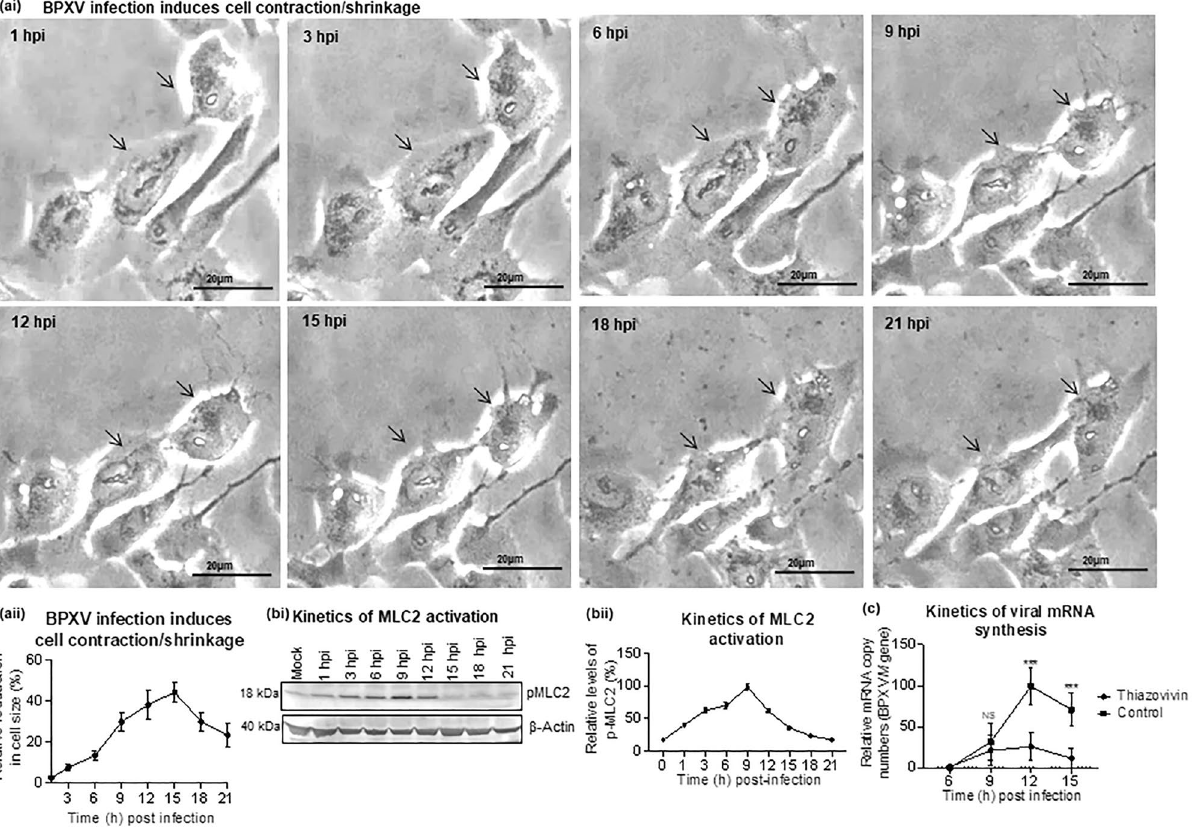
Figure 4. ROCK1/p-MLC2 signaling mediated cell contraction following BPXV infection is prerequisite for the stability of viral mRNA. ( a ) BPXV infection induces cell contraction (membrane blebbing). Vero cells were grown in chamber slides and infected with BPXV at an MOI of 5 for 1 h. Cells were subjected to live imaging. Cell morphology of BPXV infected cells at different time points are shown (ai). The histogram shows the relative reduction in cell size at different times post-BPXV infection (aii). To quantify BPXV-induced cell shrinkage, fifty cells were selected and the change in their size was measured by ImageJ at different times post-infection. The relative change in cell size (shrinkage) was expressed as a % of cell size immediately after viral infection (~ 1hpi) and the data are presented as mean with SD. ( b ) Kinetics of MLC2 activation. Vero cells were either mock-infected or infected with BPXV at MOI of 5. Cell lysates were prepared at indicated time points and subjected for detection of p-MLC2 levels in Western blot analysis. The levels of pMLC2 (upper panel) and β-actin (house-keeping control protein, lower panel) are shown (bi). The line diagram (bii) shows the band intensity of the protein. The blots were quantified by densitometry (ImageJ) and the data are presented as mean with SD. n = 3 independent experiments. See Supplementary Fig. 6d for full blots ( c ) Kinetics of viral mRNA synthesis in Thiozovivin-treated and vehicle control treated cells. Vero cells, in triplicates, were infected with BPXV at MOI of 5. Thiazovivin was applied at 3 hpi and cell lysate were prepared at the indicated time points for quantitation of viral mRNA ( M gene). n = 3 independent experiments. Error bars indicate SD. Pair-wise statistical comparisons were performed using Student’s t-test (***P < 0.001, NS